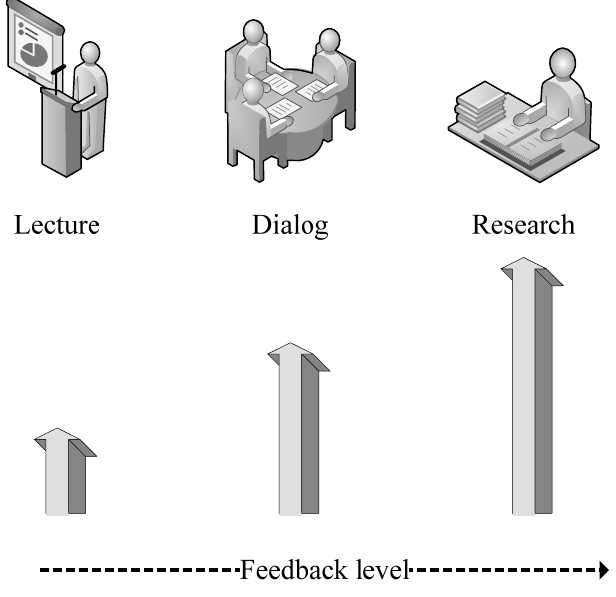
Fig. 1. Feedback level depending on the teaching